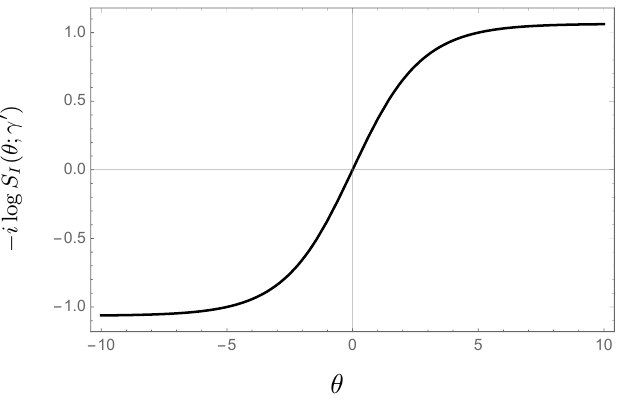
Figure 6 . The identical particle scattering phase as a function of the rapidity for some indicative value of (cid:13) 0 . The key feature is that for large (cid:18) the amplitude saturates. Note that this amplitude is also valid in the RSOS version of the S-matrix with (cid:13) 0 ! k +2. The amplitude is a phase which we plot in (cid:12)gure 6. The important point is that for large enough (cid:18) the amplitude saturates. In order calculate the asymptotic value we